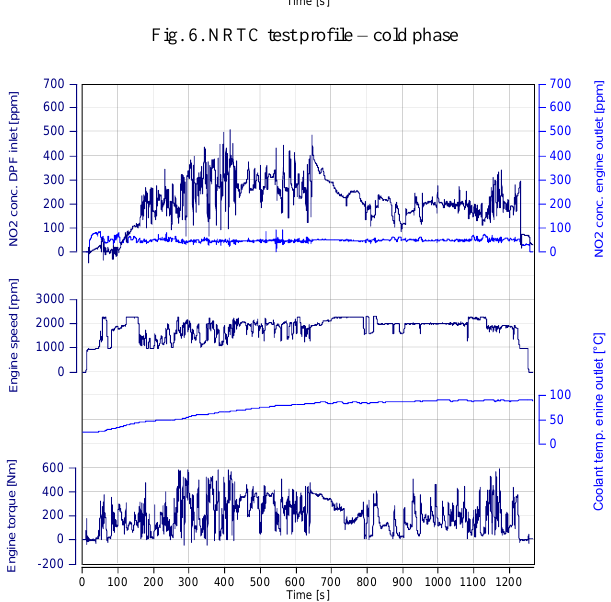
Fig. 6. NRTC test profile – cold phase